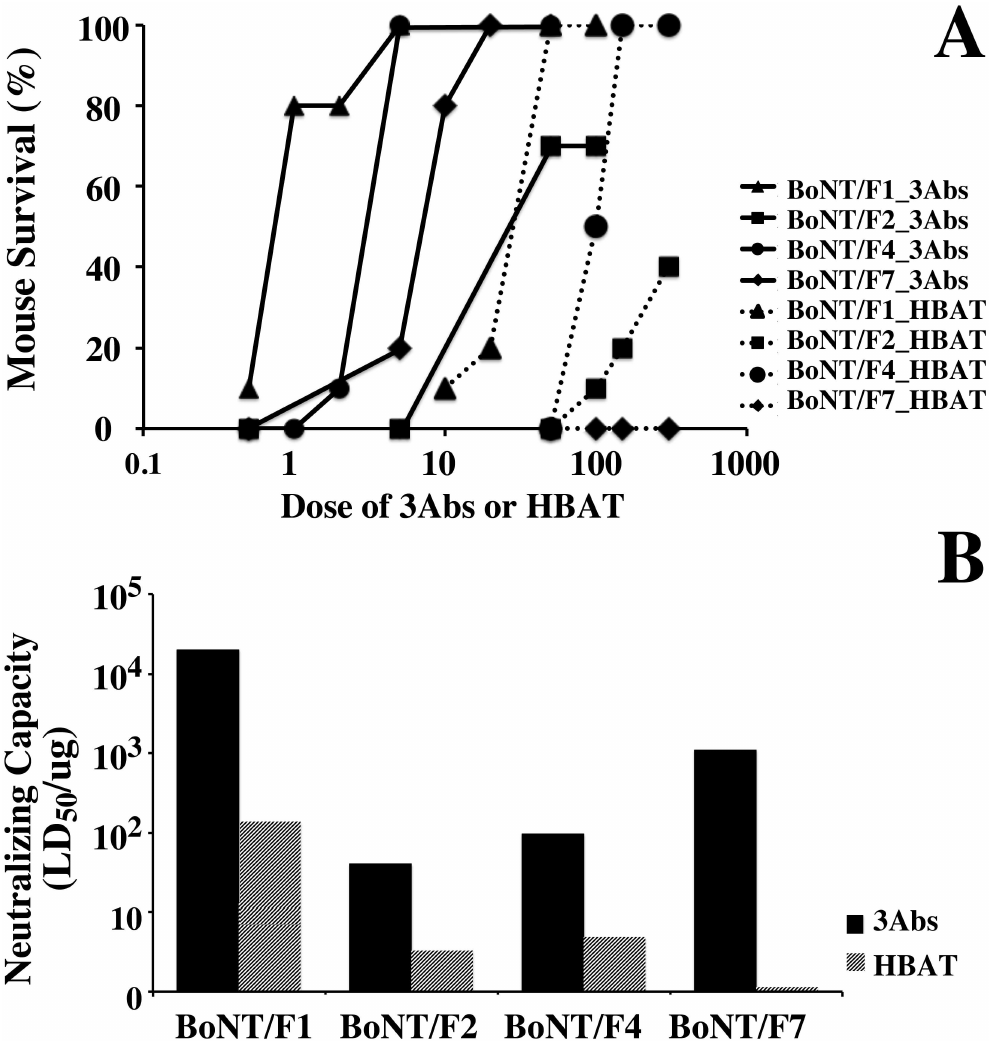
Fig 4. Protection of mice from BoNT/F subtypes challenged by HBAT or triple mAb combination. (A) Mouse survival followingintoxicationwith different toxin subtypes. The combination of 6F5.1/6F11/6F13 (3Ab) rescued mice at much lower dosage(the solid lines) than the equine-derivedHBAT showingwith dash line. (B) Neutralizing capacity of HBAT and triple mAb combination (LD 50 / μ g), calculatingby toxin amount (LD 50 ) dividedby HBAT or mAbs dosage ( μ g) that rescue > 70% of